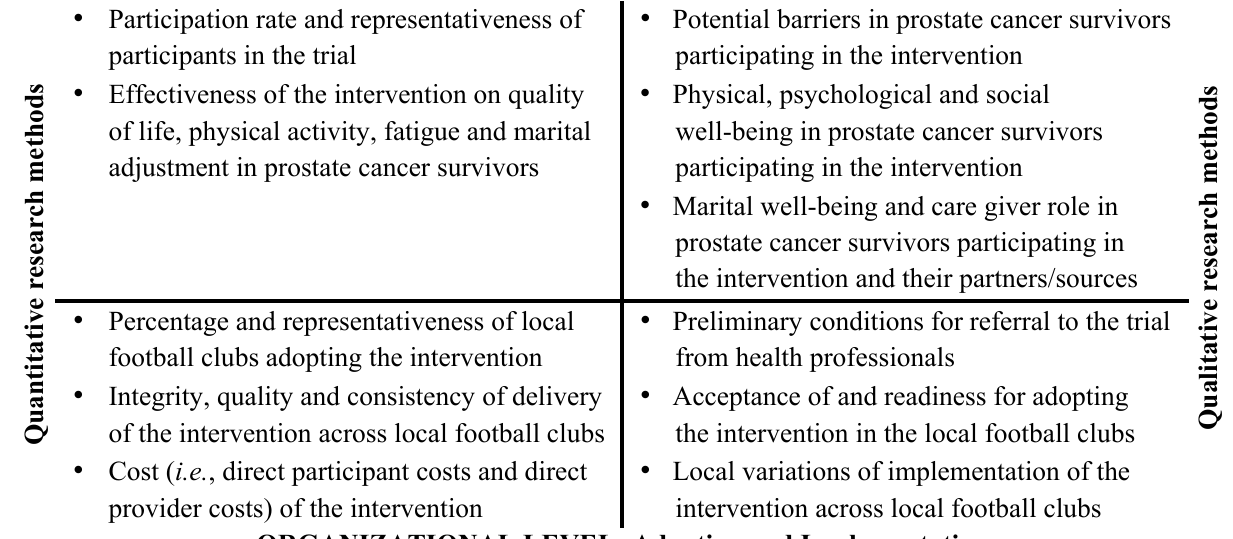
Figure 1. Research focus areas across the RE-AIM framework